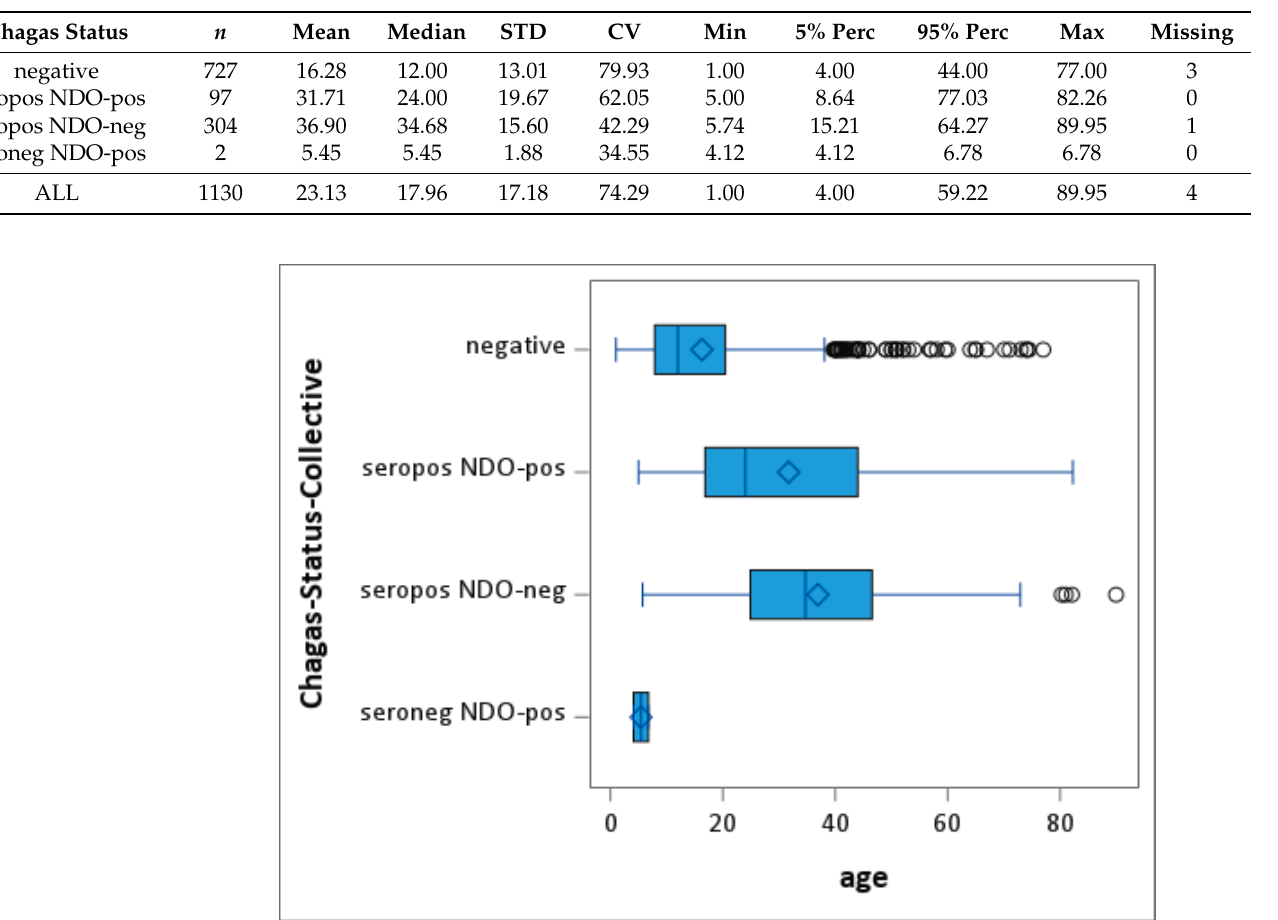
Figure 2. Box plots of age distribution by Chagas status in the entire study population ( n = 1134). Age distributions in all classes of the Chagas status show a strong, statistically sig- nificant effect in an ANOVA model (global F-test, p < 0.0001). Looking into the least-square means for the group effects, this significance level holds true for both tests between the “negative” and the “sero-positive and NDO-positive” groups, as well as the “sero-positive and NDO- negative” groups ( t -test, p < 0.0001). The test for “sero-negative and NDO-pos- itive” does not show a significant result ( t -test, p = 0.3133).